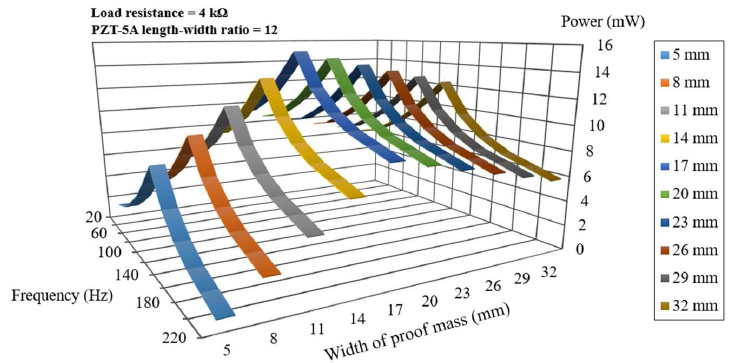
Figure 3. Output power at varying length-width ratios of PZT-5A.